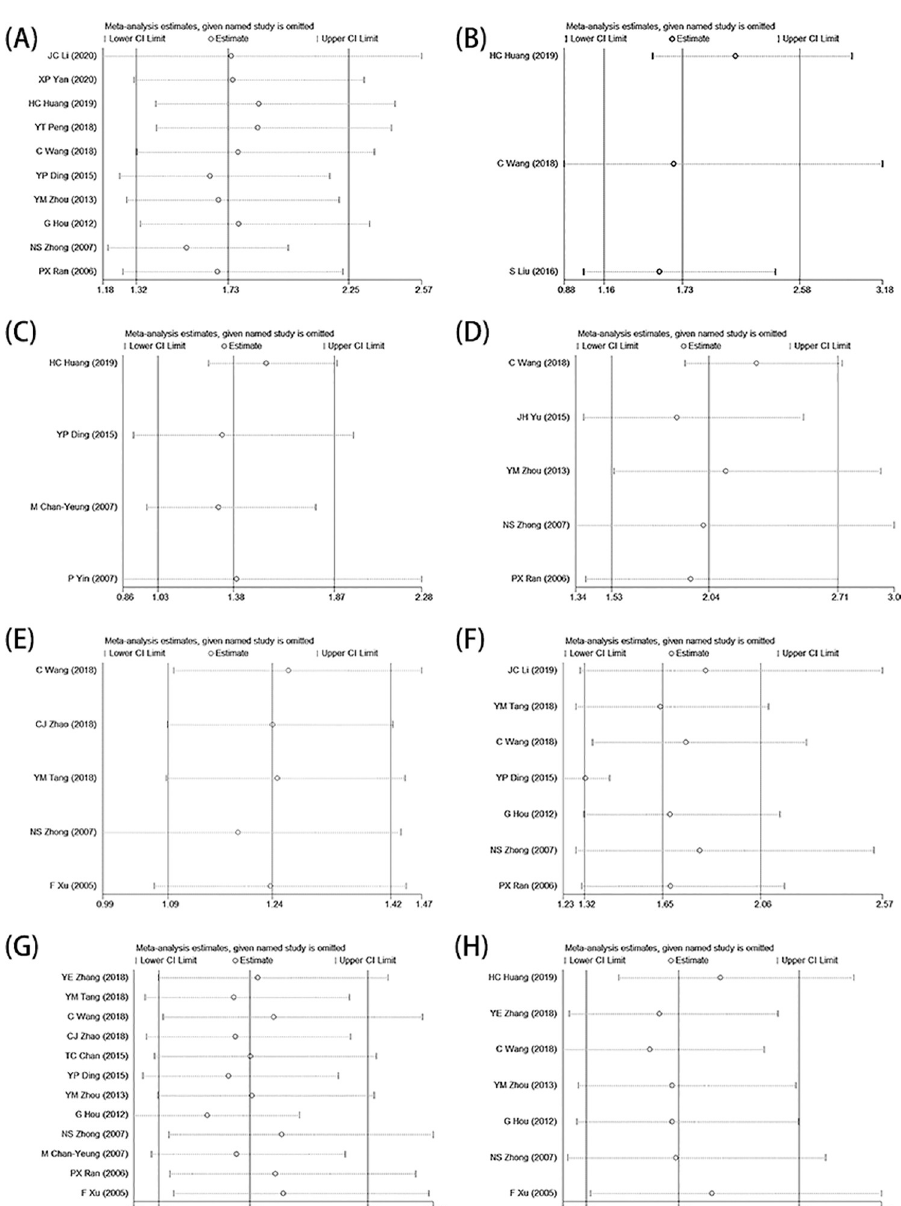
Fig 2. Results of sensitivity analysis. (A): BMI < 18.5 kg/m 2 . (B): Exposure to PM2.5. (C): Passive smoking history. (D): Family history of respiratory diseases. (E): Residence. (F): Exposure to biomass burning emissions. (G): Smoking history. (H): Male